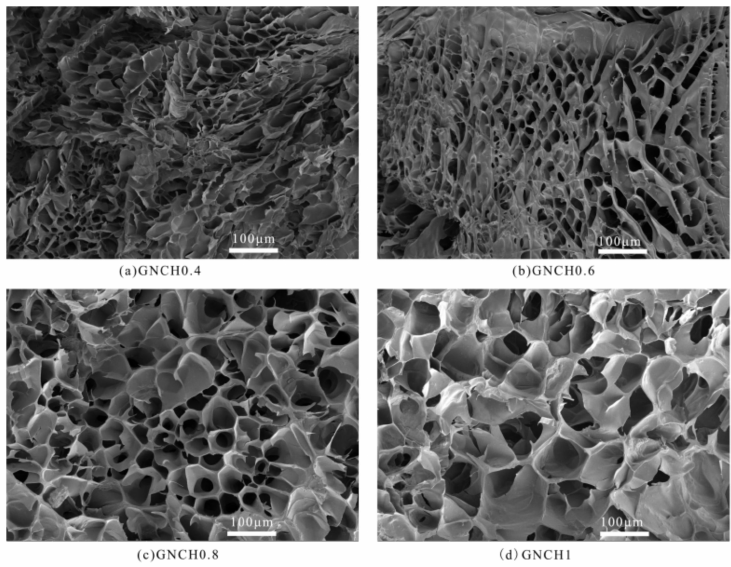
Figure 3. SEM images of hydrogels ( a ) GNCH0.4, ( b ) GNCH0.6, ( c ) GNCH0.8, ( d )